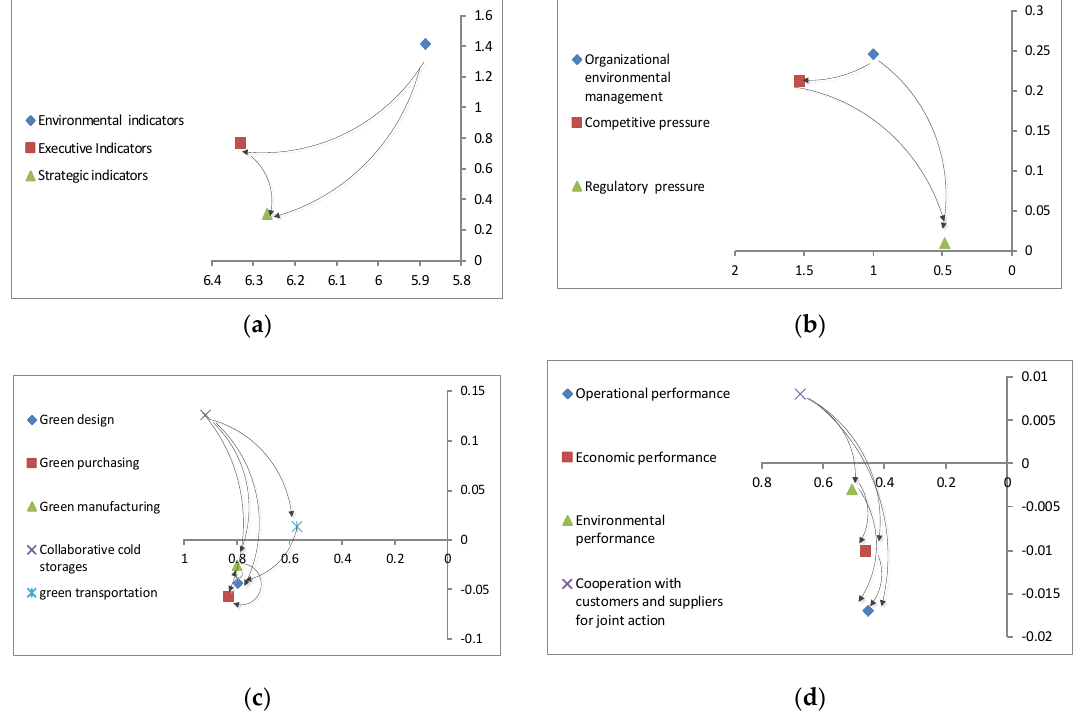
Figure 2. The network of influential relationships: ( a ) demonstrates the internal e ff ects of main category of performance indicators. ( b – d ) describes the internal e ff ects of KPIs in respectively environmental, executive, and strategic categories.